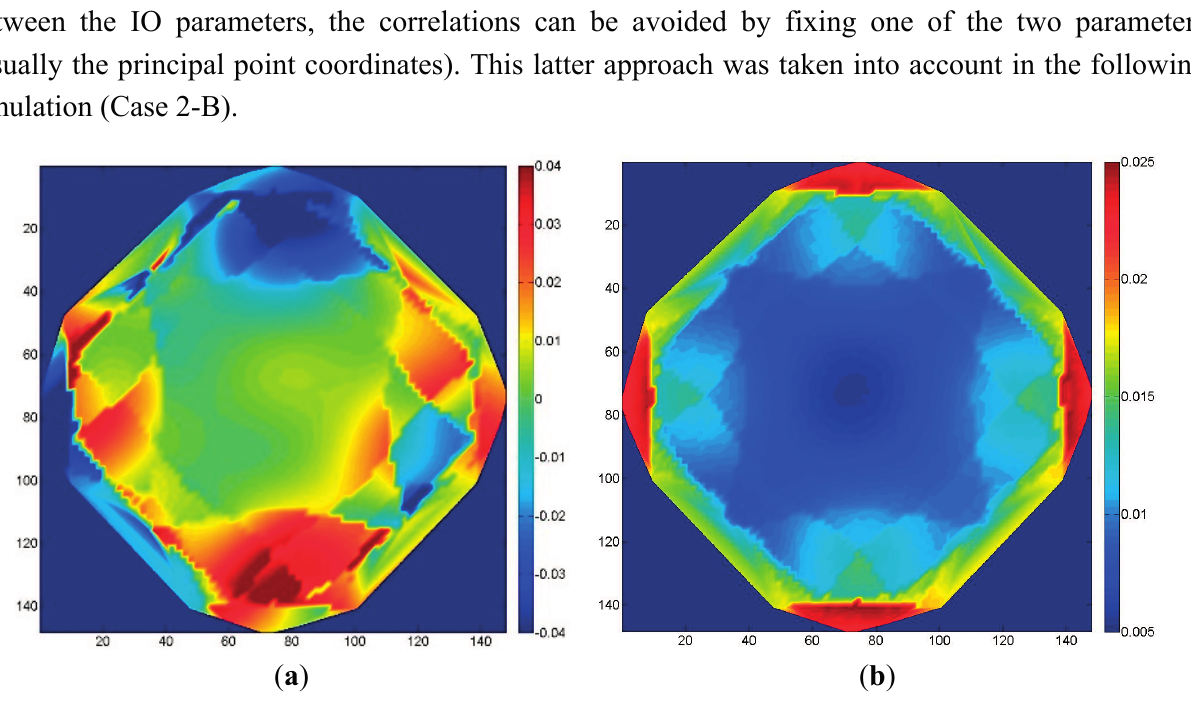
Figure 7. Case 2-A: the effect of neglecting focal length changes due to the use of autofocus with eight convergent images. ( a ) Mean error; ( b ) standard deviation of the